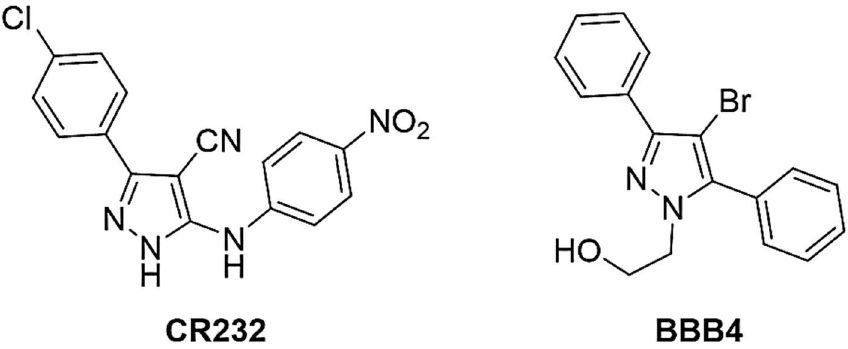
Figure 1. Chemical structure of CR232 and